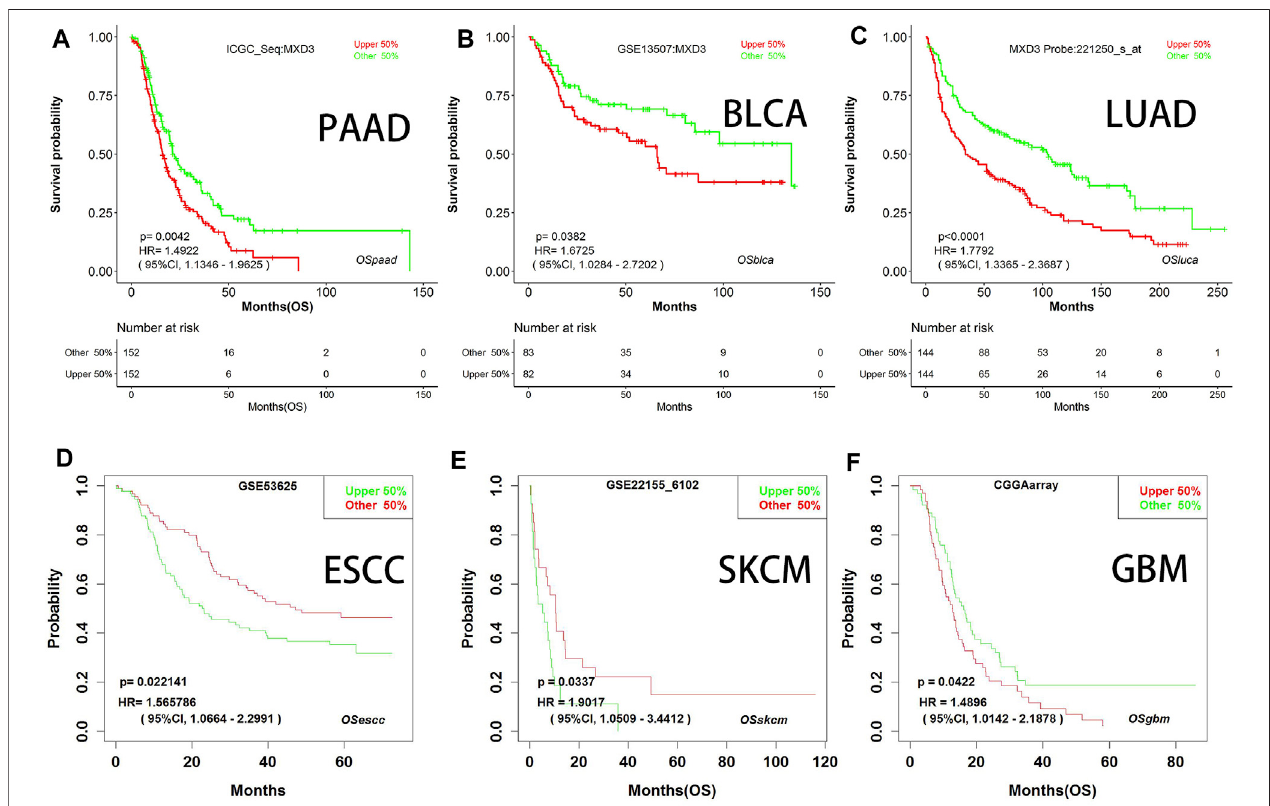
FIGURE 6 | OS with different MXD3 expression (A – F) in GEO in PAAD (A) , BLCA (B) , LUAD (C) , ESCA (D) , SKCM (E) , and GBM (F) .